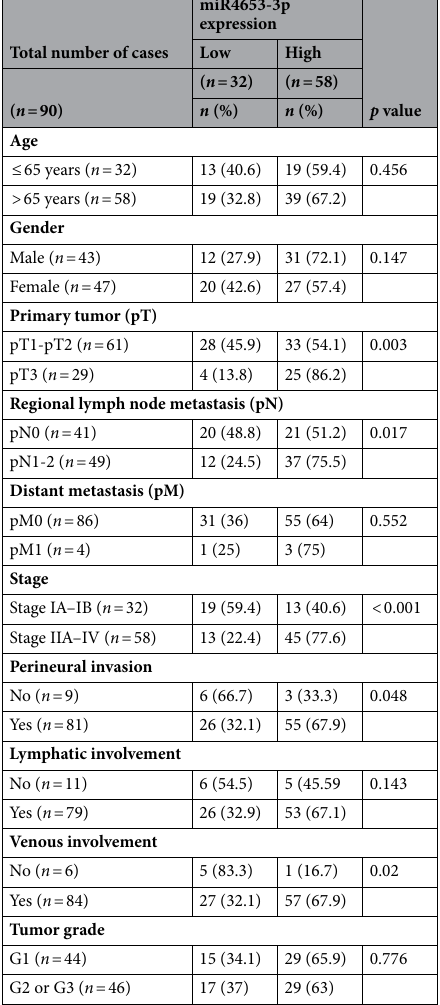
Table 1. miR-4653-3p expression and clinicopathological